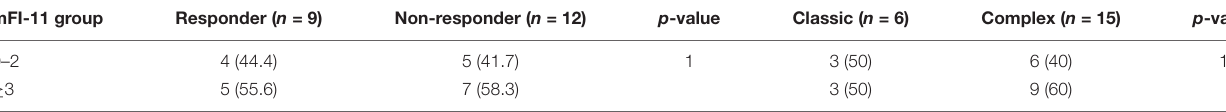
TABLE 2 | Stratification of frailty risks of the normal pressure hydrocephalus (NPH) cohort. mFI-11